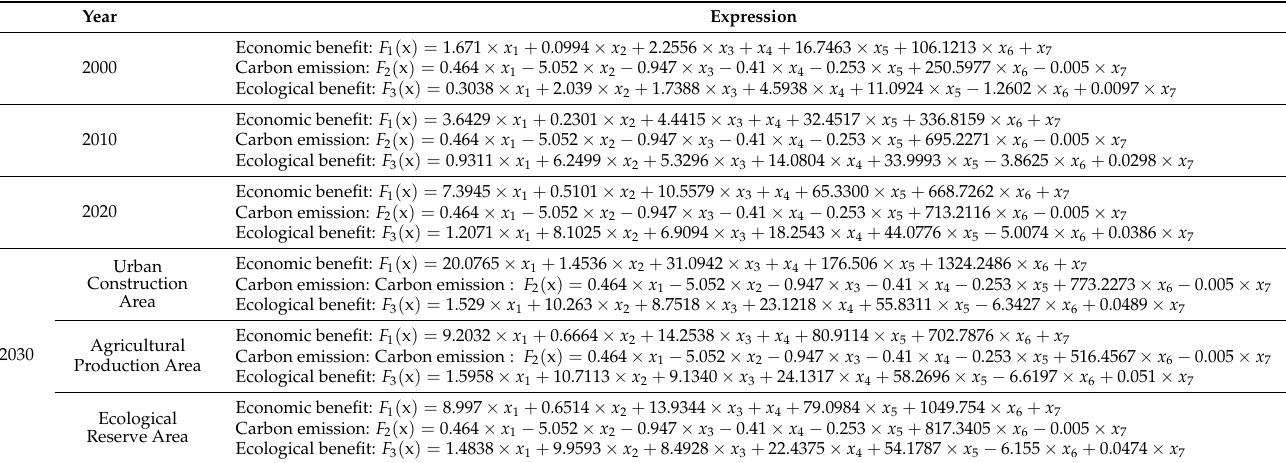
Table 6. Evaluation function